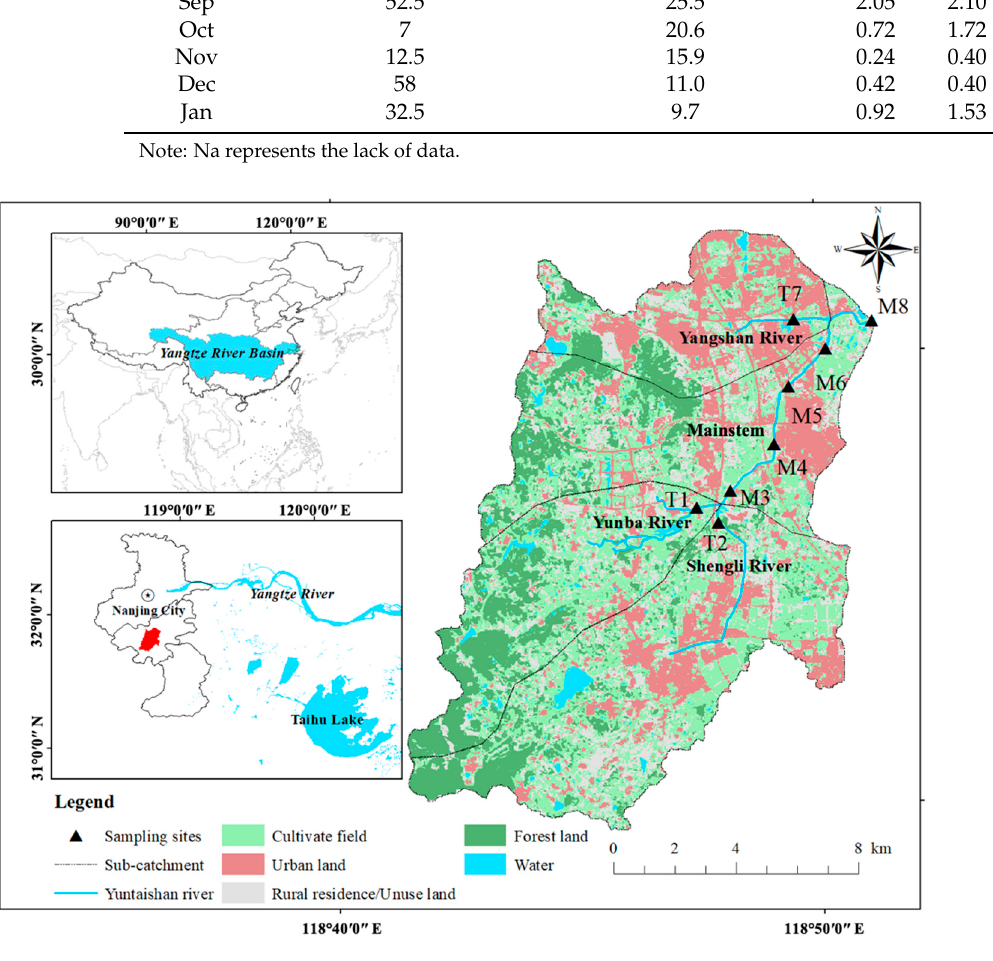
Table 2. Monthly accumulative rainfall, water temperature and discharge in Yuntaishan River